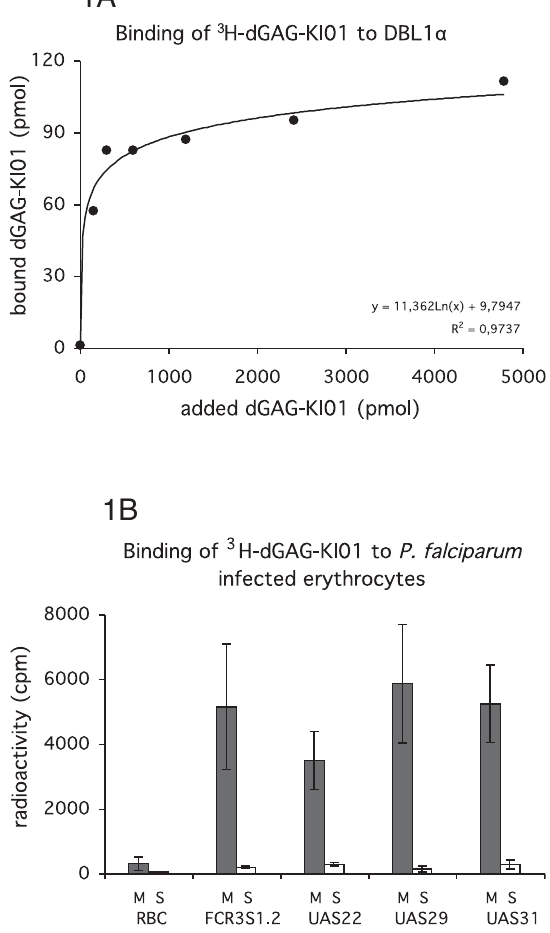
Figure 1. Binding of dGAG-KI01 to P. falciparum Antigens (A) dGAG-KI01 binding to DBL1 a was analyzed using an in-solution assay. A fixed concentration (4 l g/ml) was allowed to incubate with increasing concentrations of 3 H-dGAG-KI01. Protein with bound dGAG was recovered by membrane filtration. (B) Aliquots of rosetting parasite cultures (UAS22, UAS29, UAS31, and FCR3S1.2) were incubated with 3 H-dGAG-KI01. Cells were lysed in hypotonic buffer, and membranes (M) were separated from the supernatants (S). 3 H-dGAG-KI01 bound to DBL1 a and cell compartments were analyzed by scintillation counting. DOI: 10.1371/journal.ppat.0020100.g001